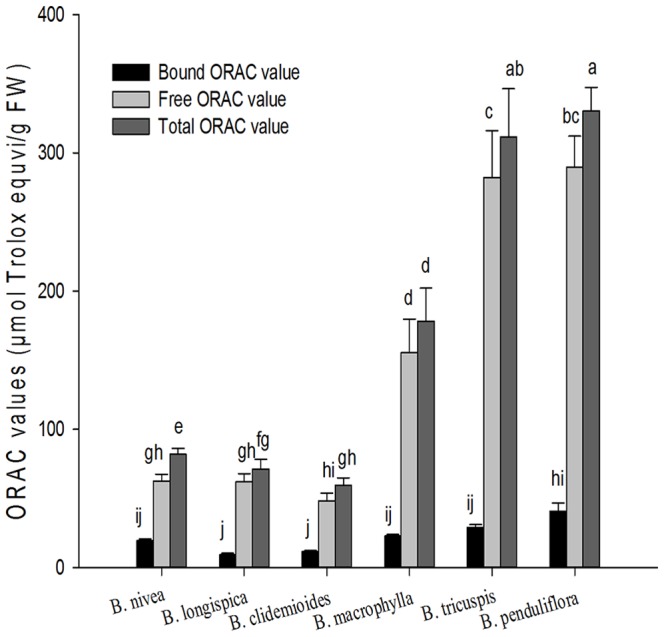
ORAC values in six species of ramie leaves (mean ± SD, n = 3).Bars with no letters in common are significantly different (p<0.05).